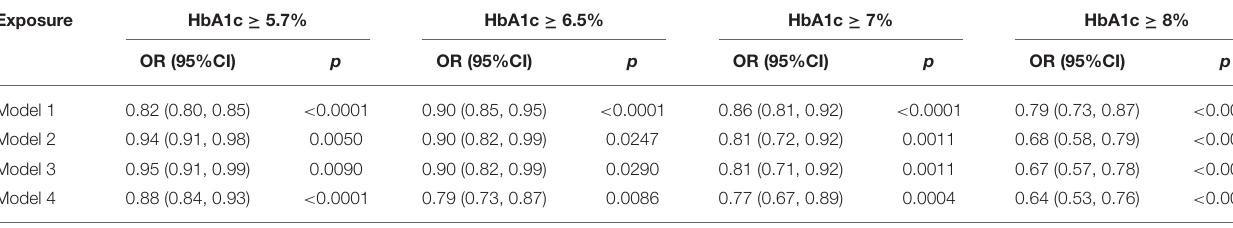
TABLE 5 | Odds ratios (per 2 g/L increase in albumin) for exceeding various HbA1c cutpoints. Exposure